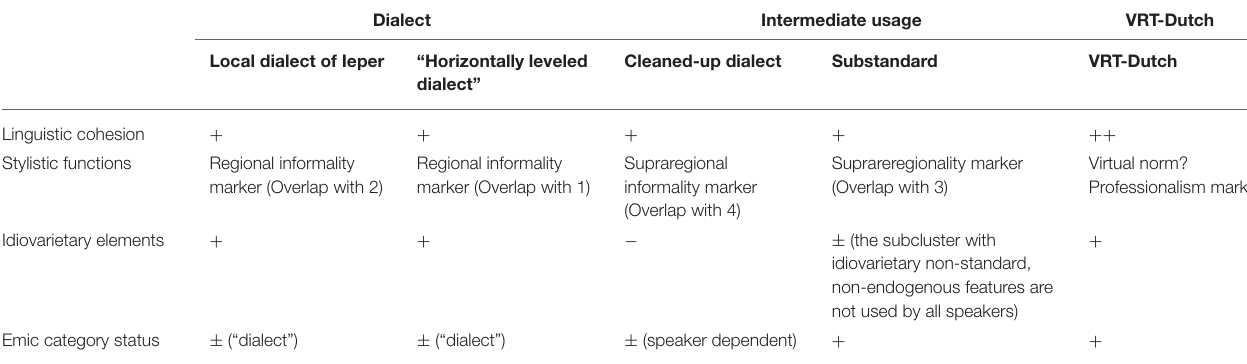
TABLE 2 | Summary variety